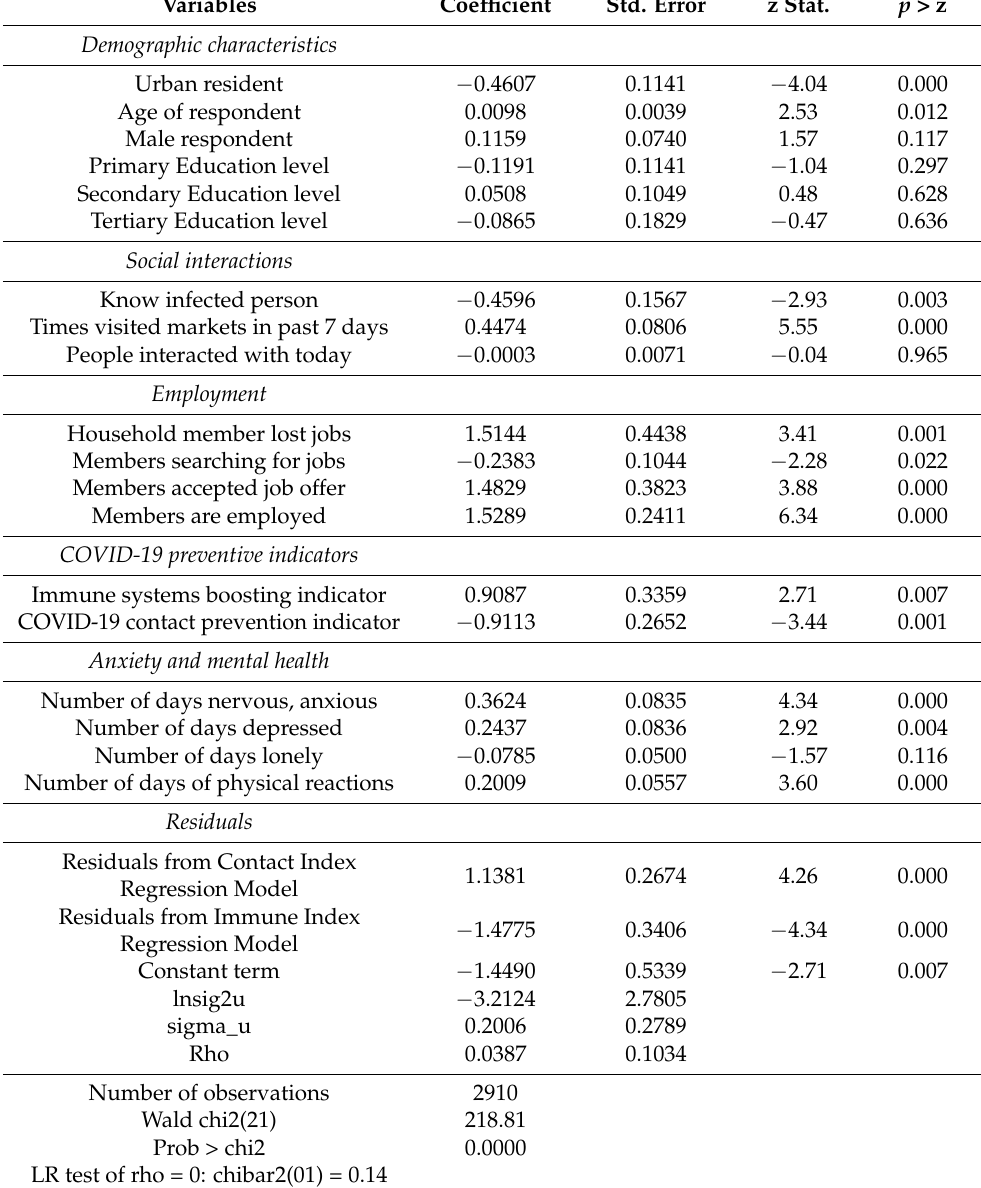
Table 4. Determinants of Vaccination Intention Based on Random Effects Probit